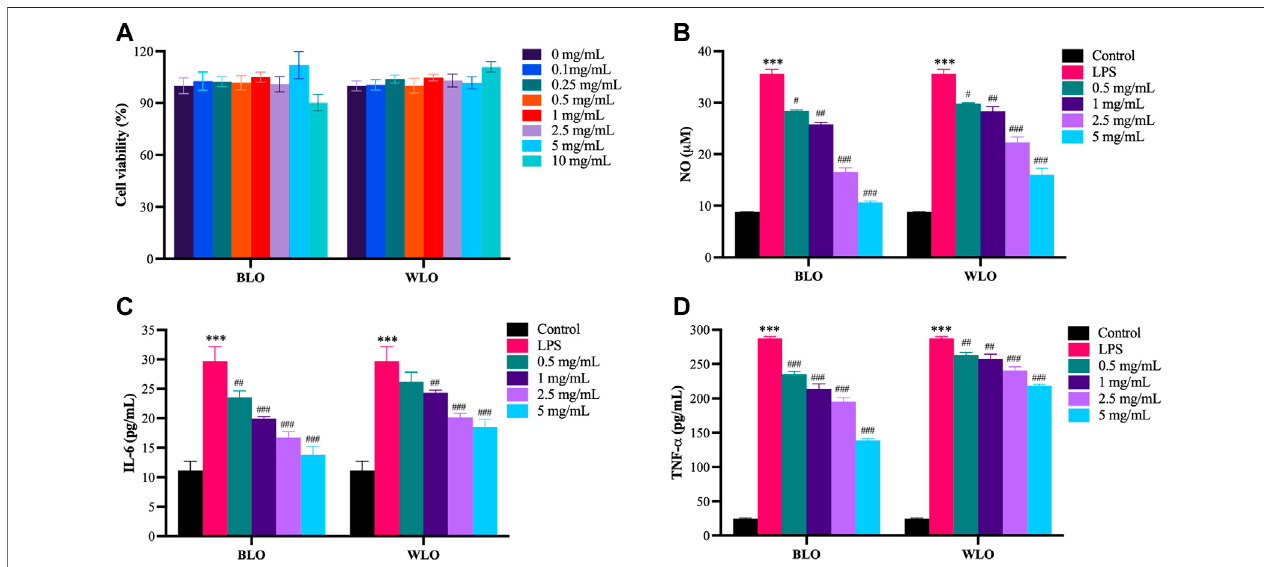
FIGURE 1 | Anti-in fl ammatory effects of BLO and WLO in LPS-induced RAW264.7 cells (X ± SEM, n = 3). (A) : Cytotoxic effects of BLO and WLO on RAW264.7 cells.ThecellswereincubatedwithdifferentconcentrationsofBLOandWLOfor24 h,andthenthecellviabilitywasdetectedbyCCK-8assay. (B – D) :EffectsofBLOand WLOon NO (B) , IL-6 (C) and TNF- α (D) release inLPS-challenged RAW264.7 cells.TheRAW264.7 cellsweretreatedwithBLOor WLOfor1 hand thenadded LPSfor an additional 18 h *** p < 0.001 vs. Control group. # p < 0.05, ## p < 0.01, ### p < 0.001 vs. LPS